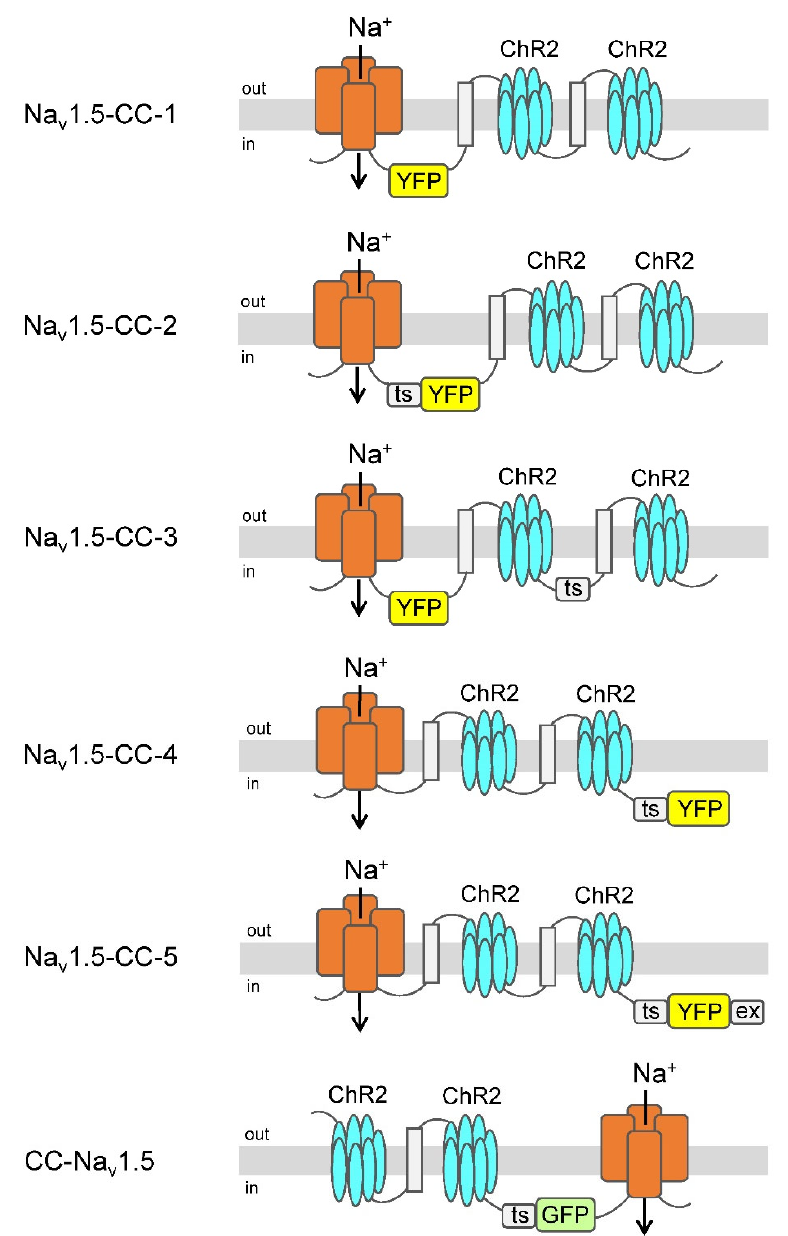
Figure 1. Light-sensitive voltage-gated Na + channels. ChR2 was coupled as a dimer either to the C- or N-terminus of the human cardiac voltage-gated Na + channel (Na v 1.5). The seven transmembrane regions of ChR2 (blue), the four large domains of Na v 1.5 (red), and the membrane-spanning region of the β subunit of the human H + /K + -ATPase (light gray) including the flanking linker peptide [GGGS] 3 (symbolized by a black line) are illustrated. Variants of the green fluorescent protein (YFP or GFP) were incorporated either into linker regions or at the C-terminal end. Some of the channel constructs contained the Golgi-to-plasma membrane trafficking signal (ts) [48] and, in the case of Na v 1.5-CC-5, also an ER export motif [49]. For detailed amino acid composition, see “Supplementary Materials”.